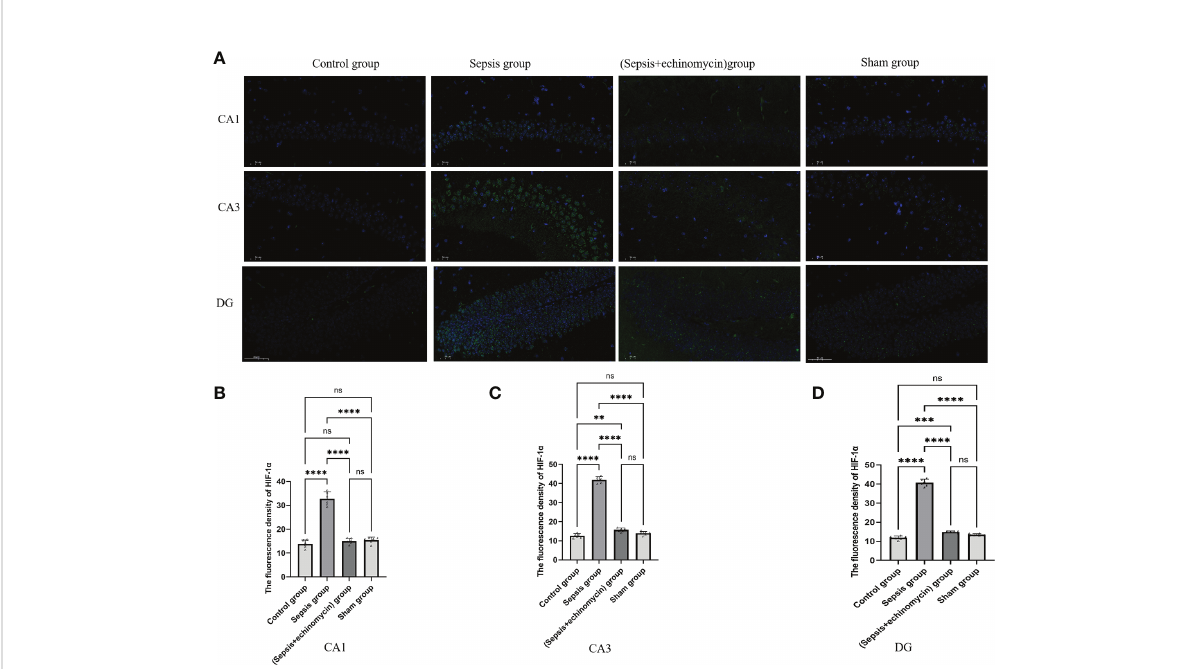
FIGURE 6 Immuno fl uorescence detection the HIF-1 a expression of hippocampus tissue CA1, CA3 and DG area (A) . The average nuclear HIF-1 a fl uorescence density of hippocampus in three fi elds of view per slice was analyzed in each group by the ImageJ software (B – D) . Compared with other three groups, sepsis up-regulated the HIF-1a expression in the hippocampus of mice.**: p < 0.01, ***: p < 0.001,****: p < 0.0001, ns: p >